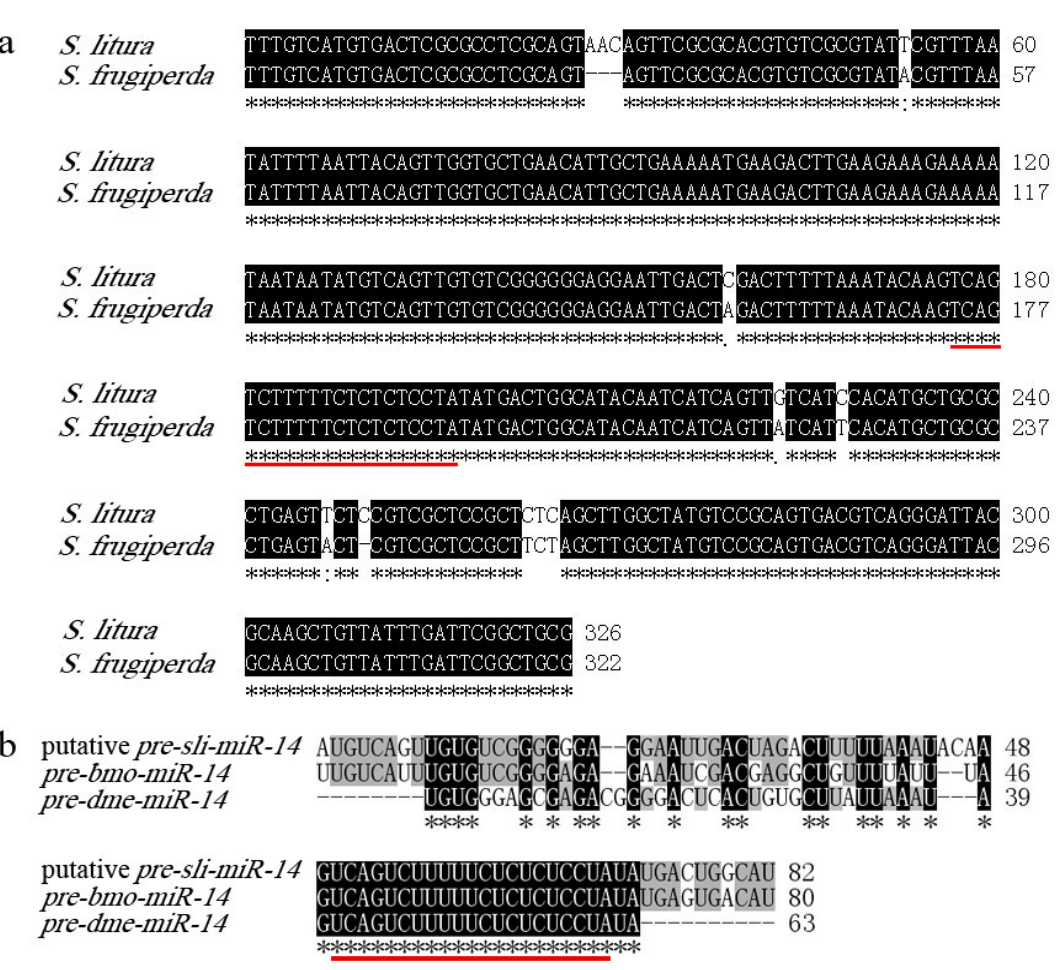
Figure 2. ( a ) The sequence alignment of partial sequences of pri-miR-14 between S. litura and S. frugiperda ; ( b ) The sequence alignment of entire sequences of pre-miR-14 among S. litura , B. mori and D. melanogaster . Black shades represent completely conserved bases. Mature sequence of sli-miR-14 was underlined by red